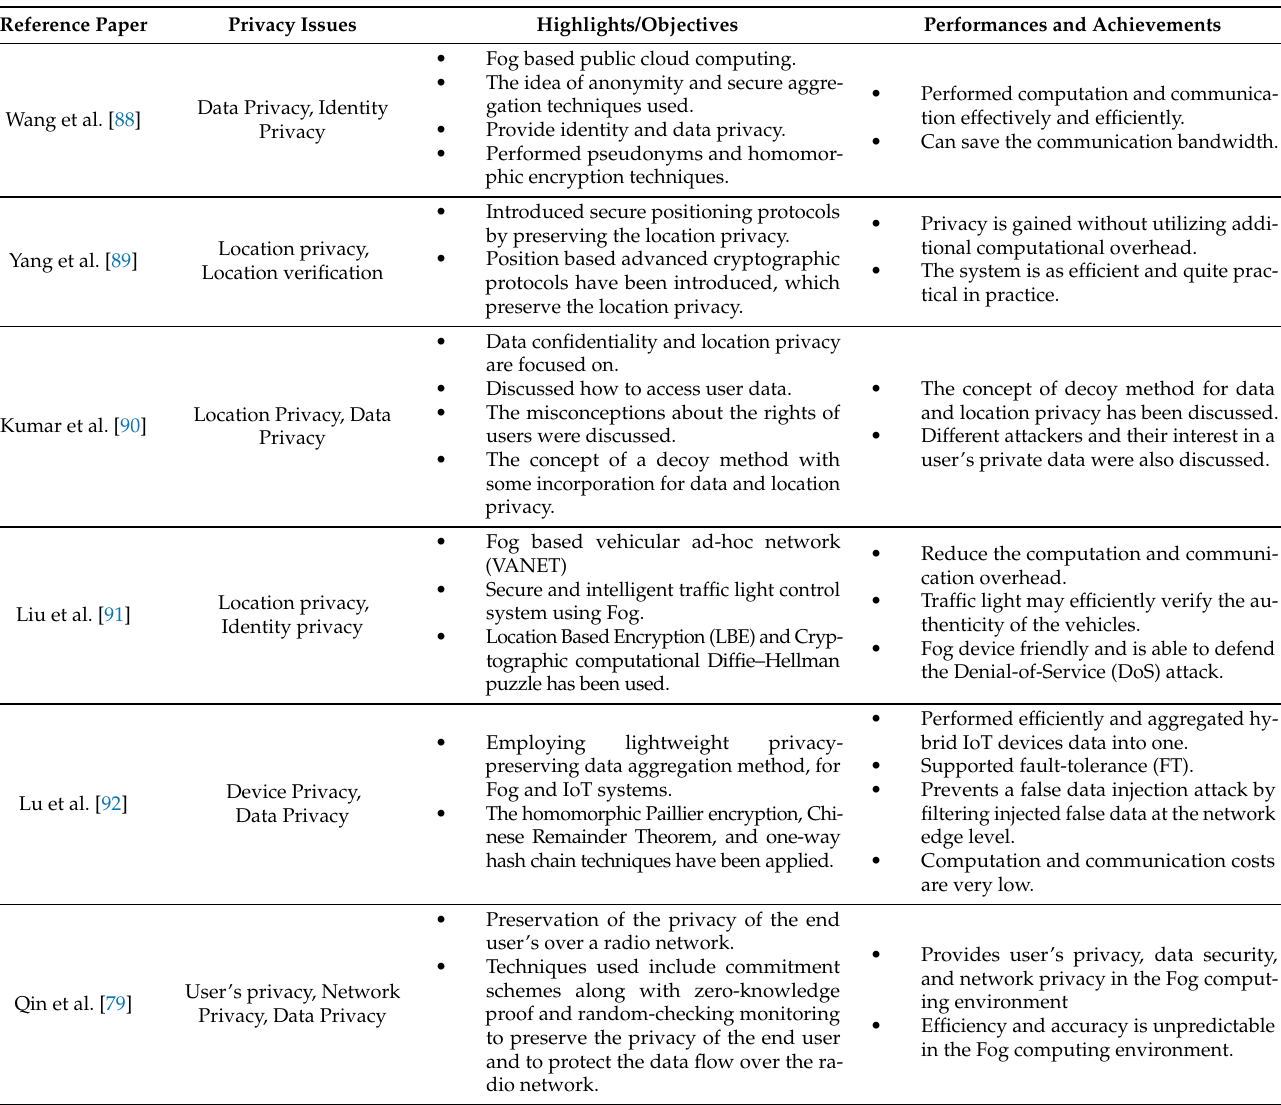
Table 7. The summary of privacy issues in the Fog environment from major survey